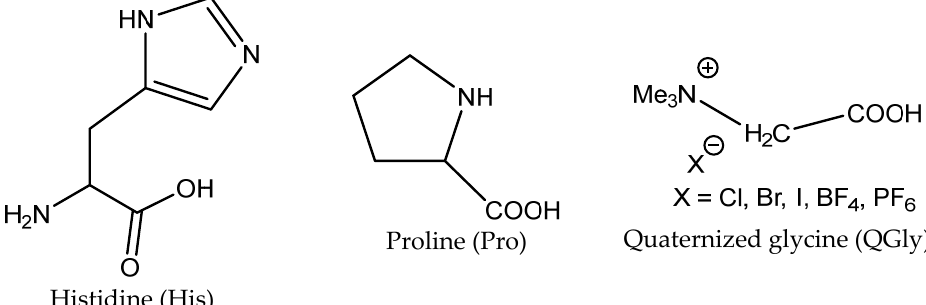
Figure 4. Structures of highly catalytically active AAs.